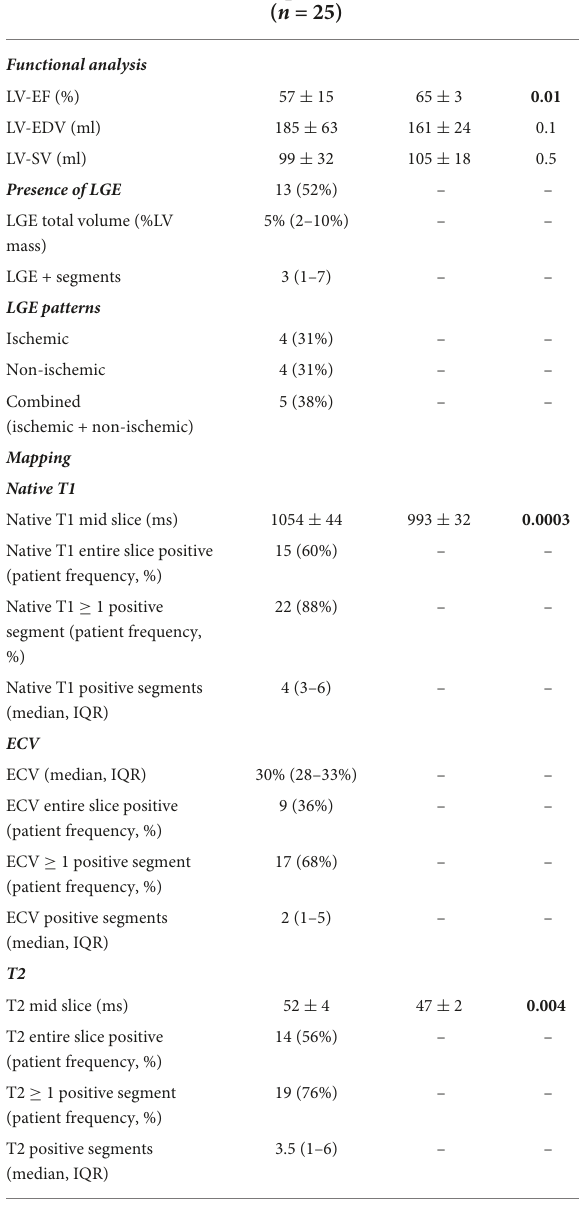
TABLE 2 CMR findings patients vs.